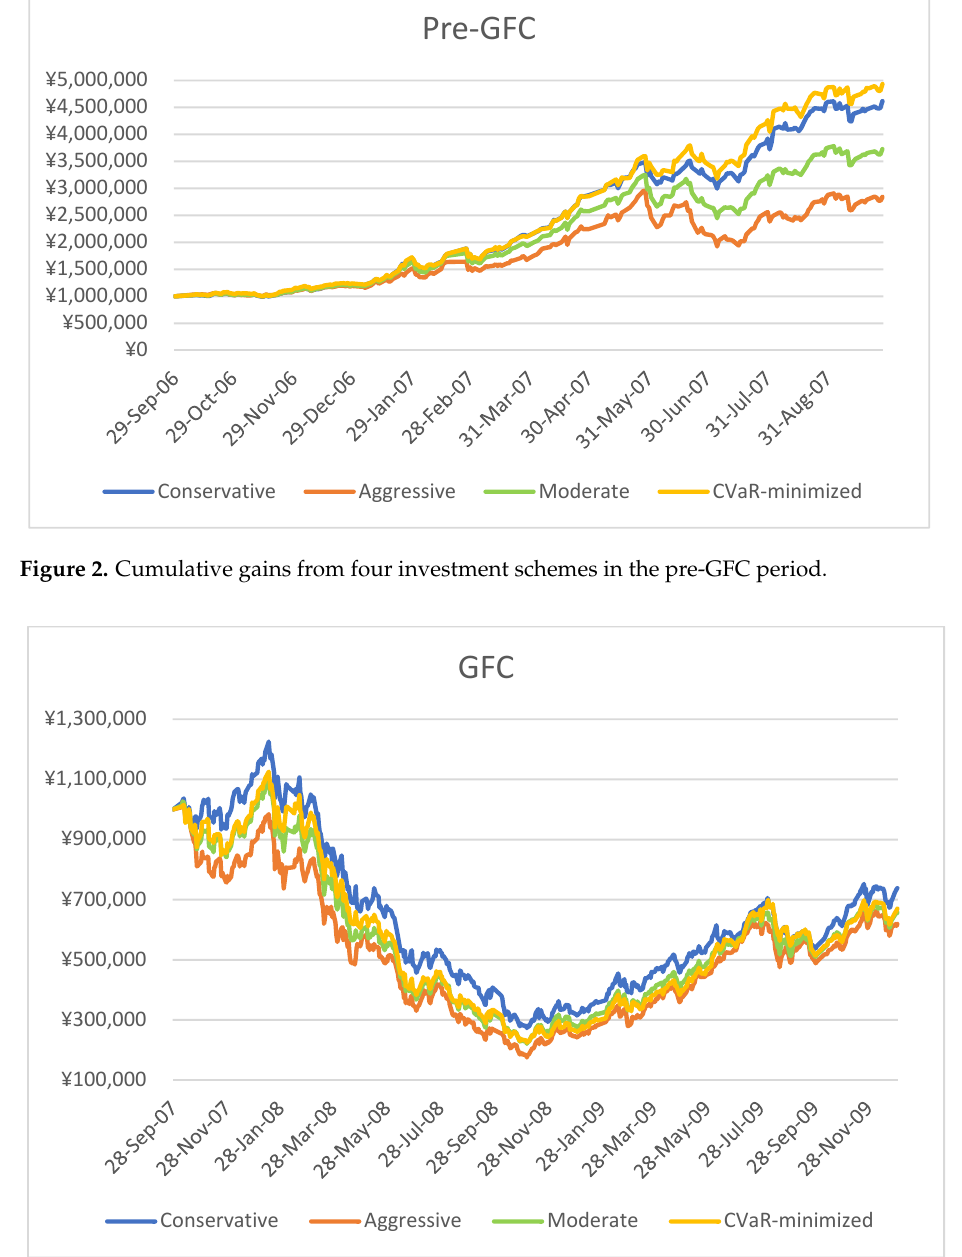
Figure 3. Cumulative gains from four investment schemes in the GFC period.